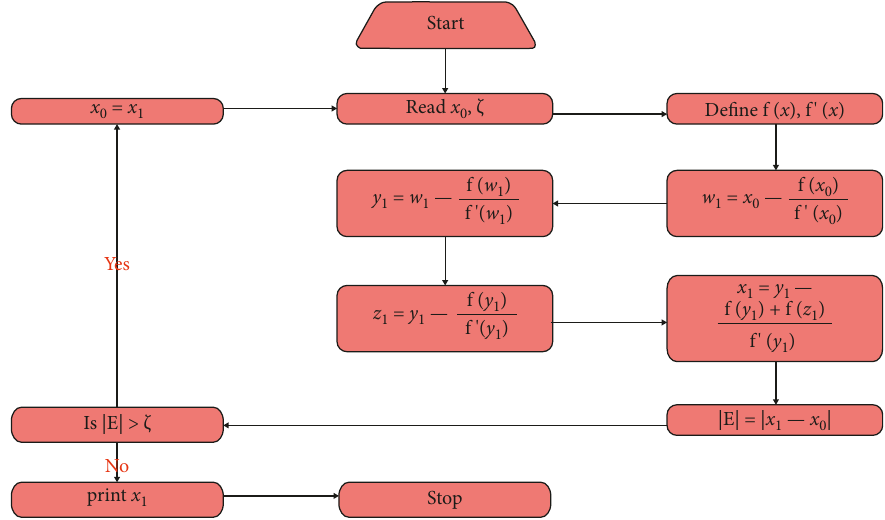
Figure 1: Flow chart for the proposed four-step hybrid method given in (9).